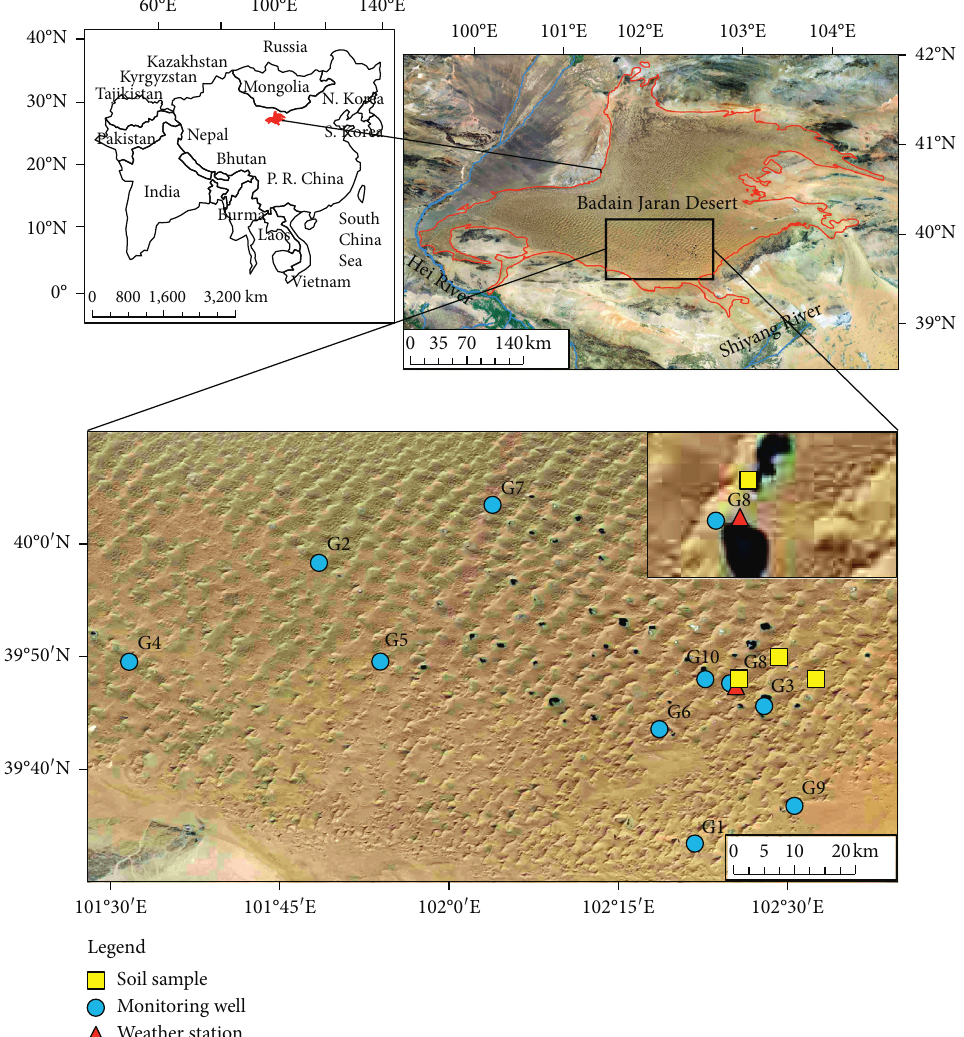
Figure 1: Location of the study area and observation